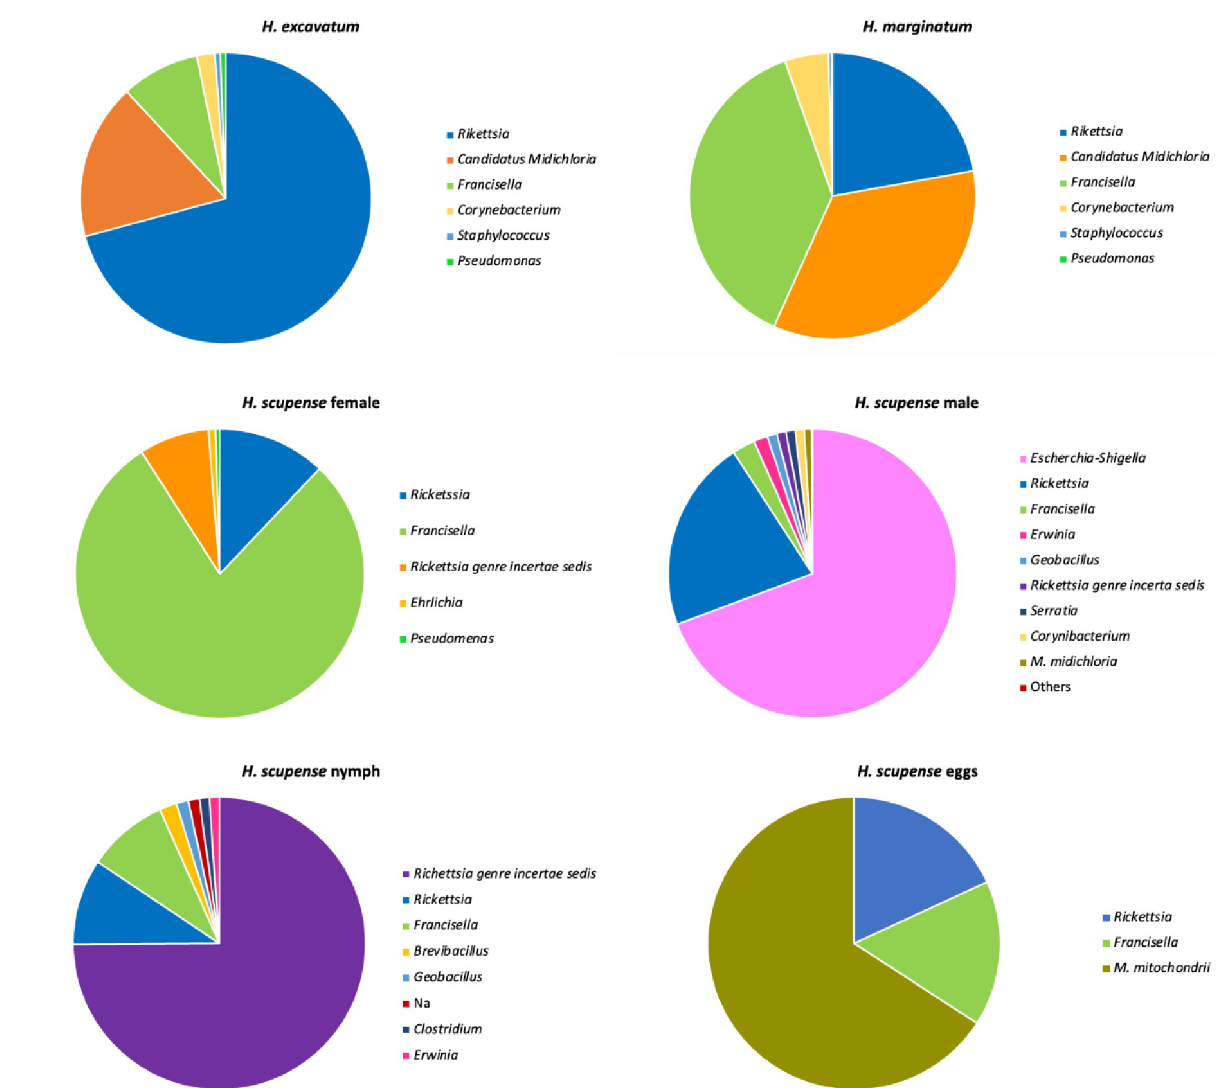
Fig 2. Relative abundance (%) of bacterial genera according to tick species and life stage of Hyalomma scupense . Organisms listed in the legend appear from top to bottom in order of highest relative abundance.